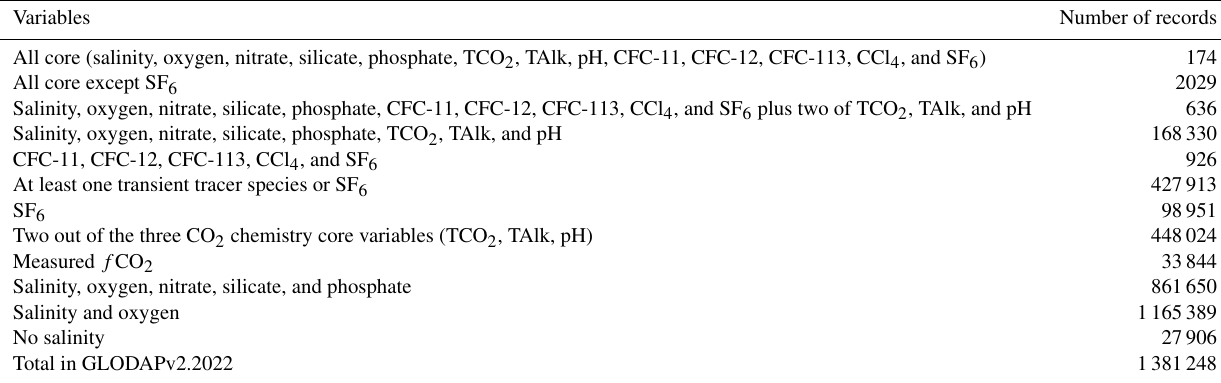
Table 8. Table listing the number of data points in GLODAPv2.2022, as well as the number of data with various combinations of variables.